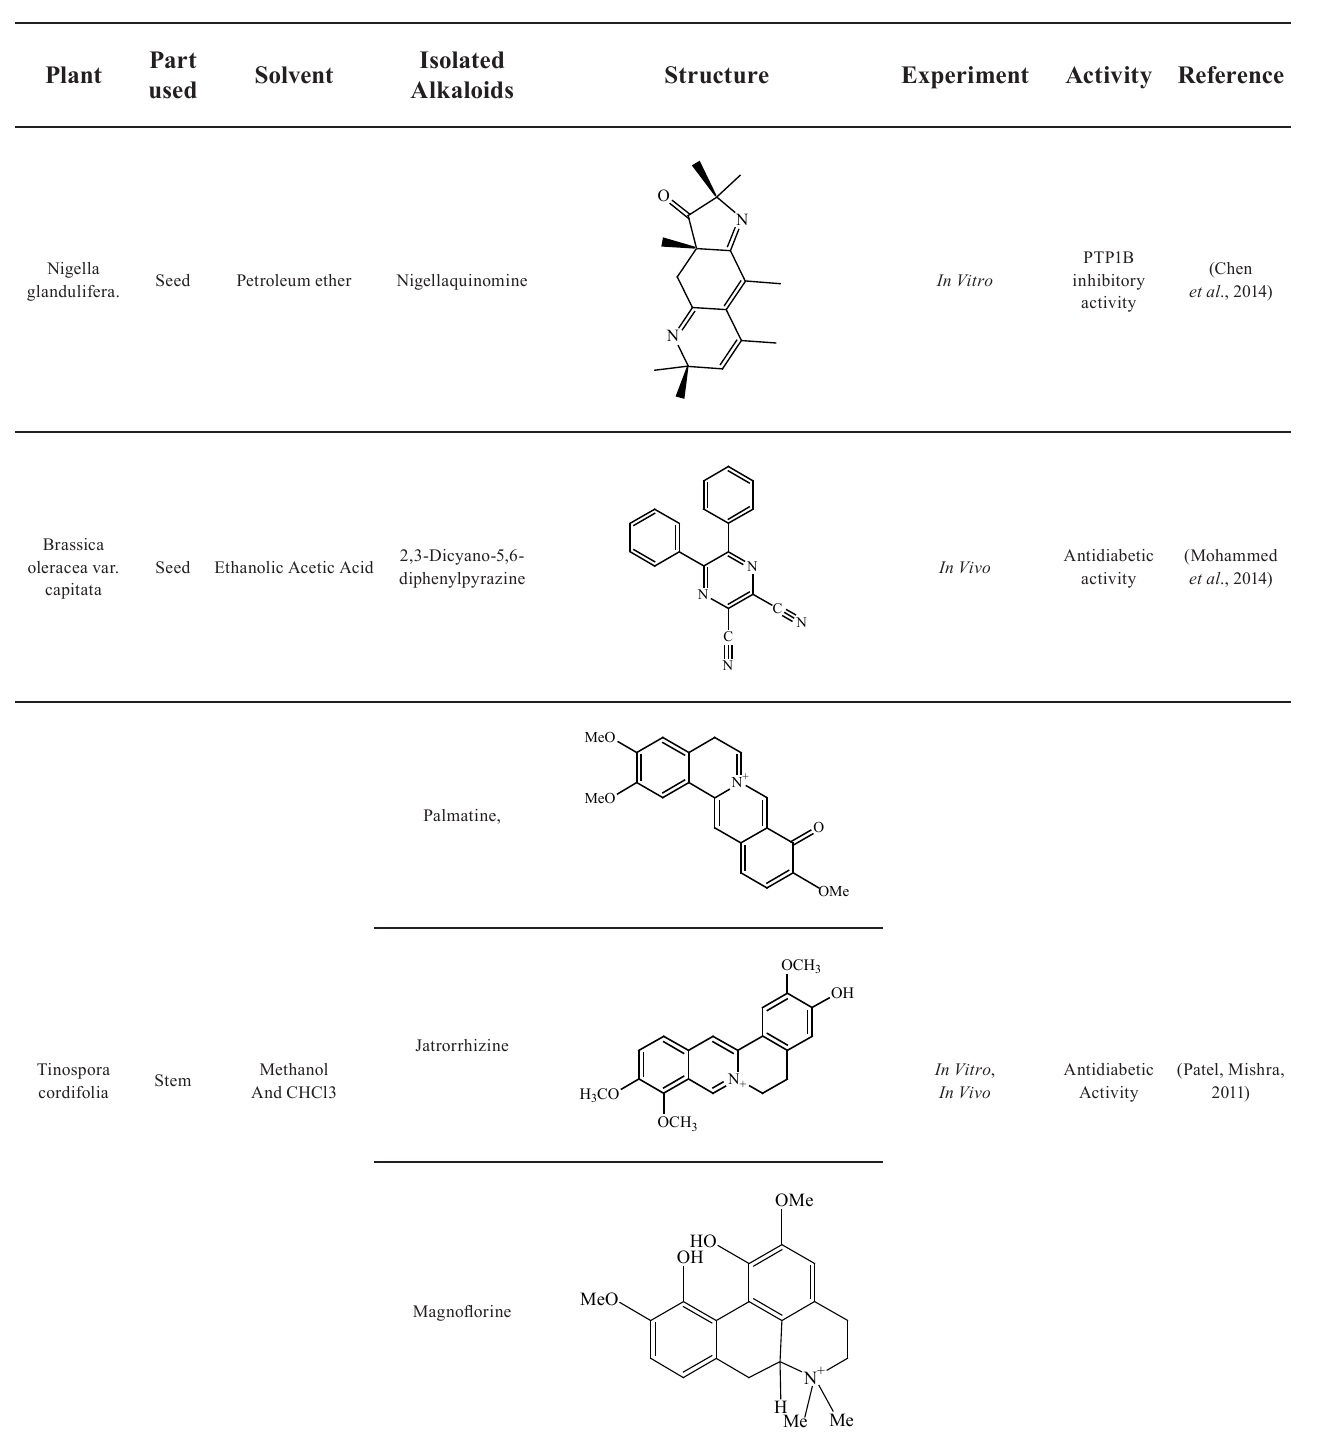
TABLE I – A lkaloids with anti-diabetic activity